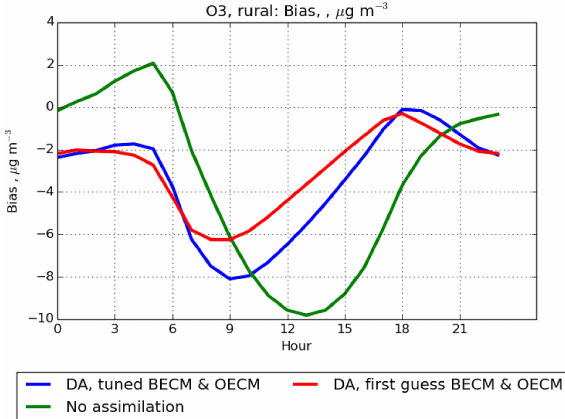
Figure 6. Diurnal variation of model bias (µgm − 3 ). The first guess assimilation setup is shown in red and the final setup in blue. The reference run with no assimilation is drawn in green. The values are shown for the rural MACC validation stations and averaged over each day of year 2012 and over the